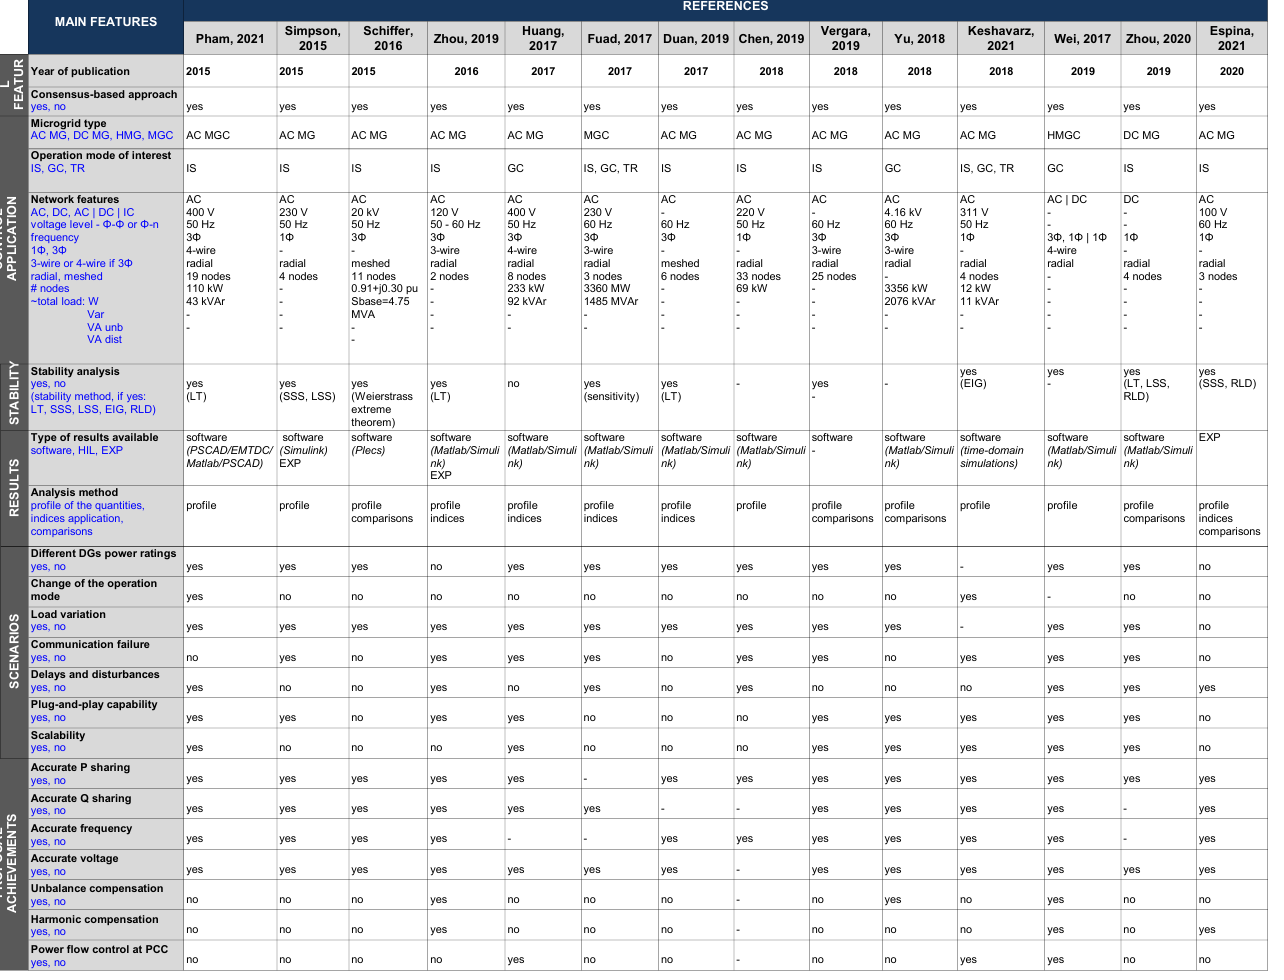
Figure 14. Publications on consensus-based control systems for MGs: general features of the control systems—part 1. Legend: Pham, 2021 [111], SimpsonPorco,